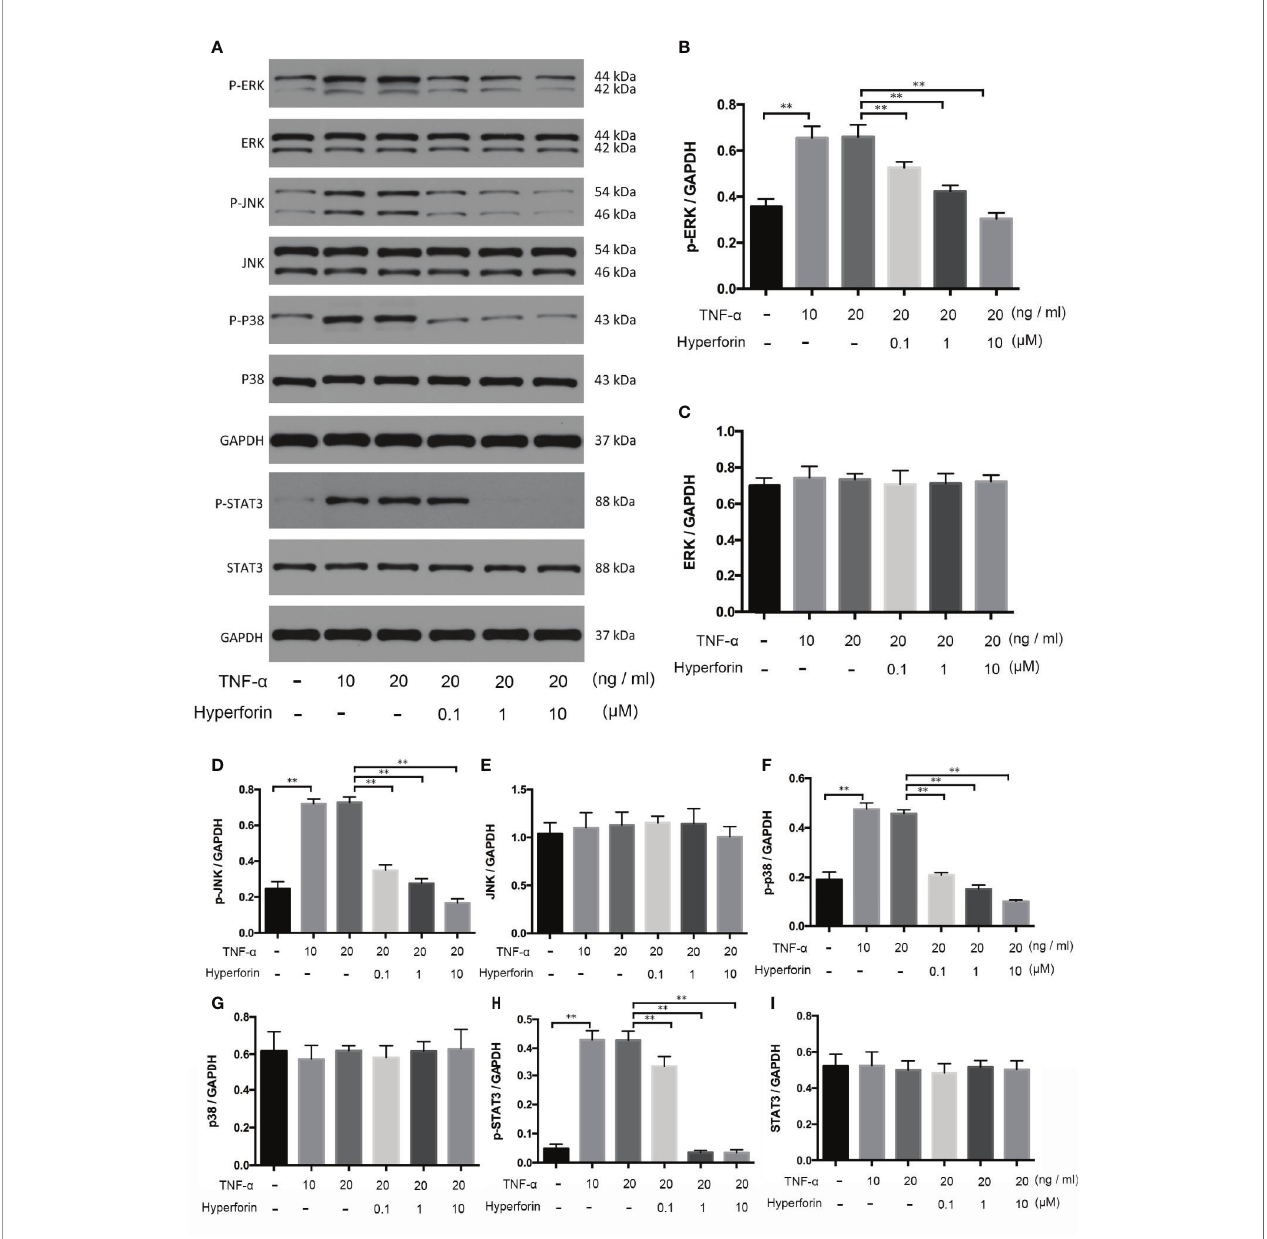
FIGURE 9 | Hyperforin inhibits phosphorylation of MAPK and STAT3 pathway components induced by TNF- a in HaCaT cells. HaCaT cells were pretreated with different doses of hyperforin, and stimulated with TNF- a . The total protein was extracted from the cells and associated protein expression was determined via western blotting (A) . The quanti fi cation data are shown in the right panel (B – I) . (n = 3 independent experiments). **P < 0.01 vs model